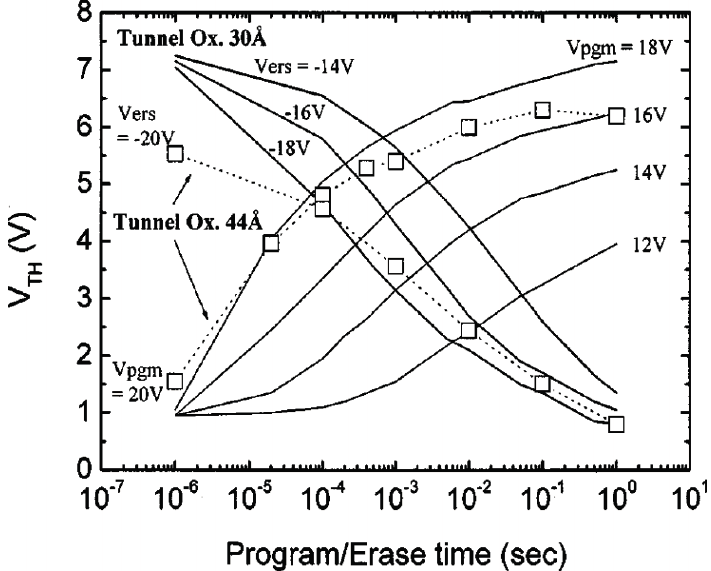
Figure 2. Program and erase characteristics of SANOS devices. Reused with permission from [34], Copyright 1997,